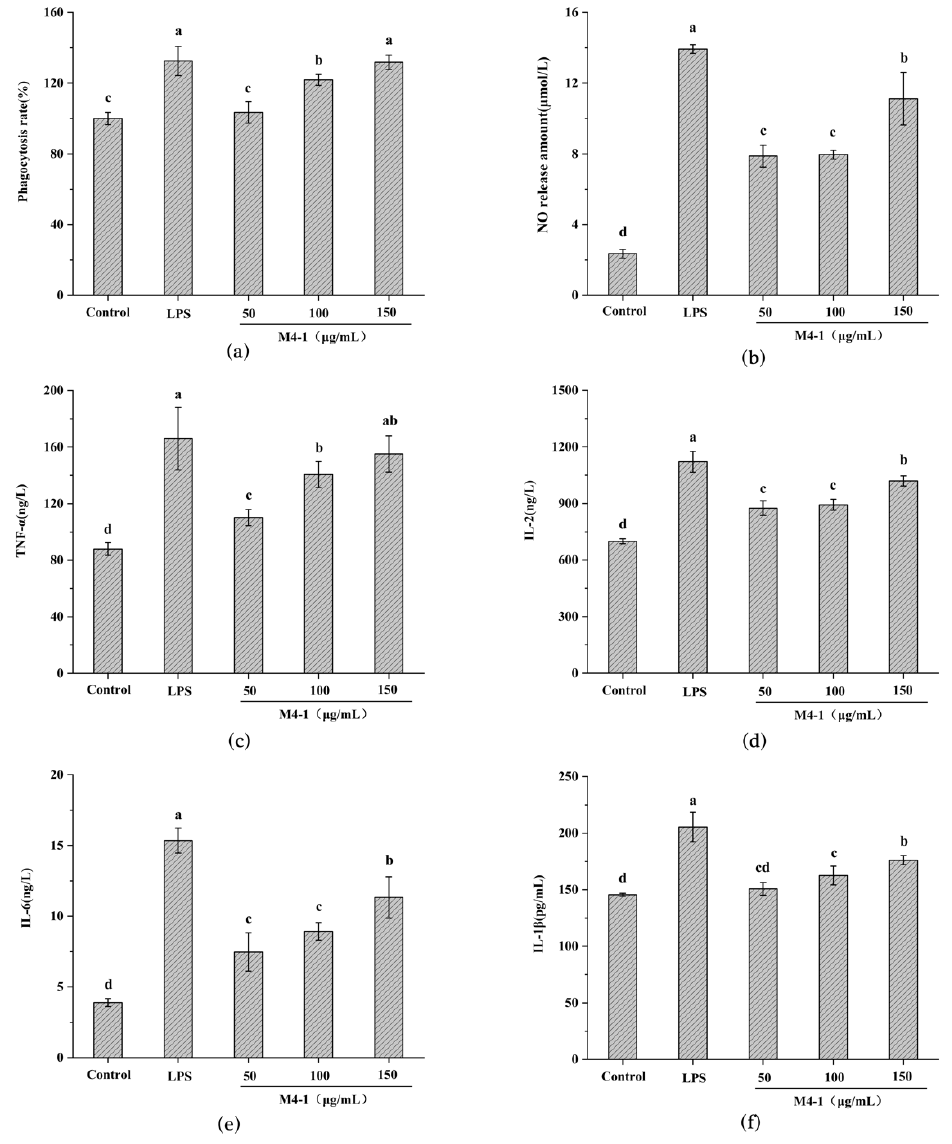
Figure 3. Evaluation of the immunomodulatory property of the M4-1 fraction. Effects of different concentrations of M4-1 components on phagocytosis of neutral red ( a ), NO release ( b ), and cytokines TNF- α ( c ), IL-2 ( d ), IL-6 ( e ), and IL-1 β ( f ) in macrophages. Values in columns a–d with different superscripts indicate significant differences ( p < 0.05).